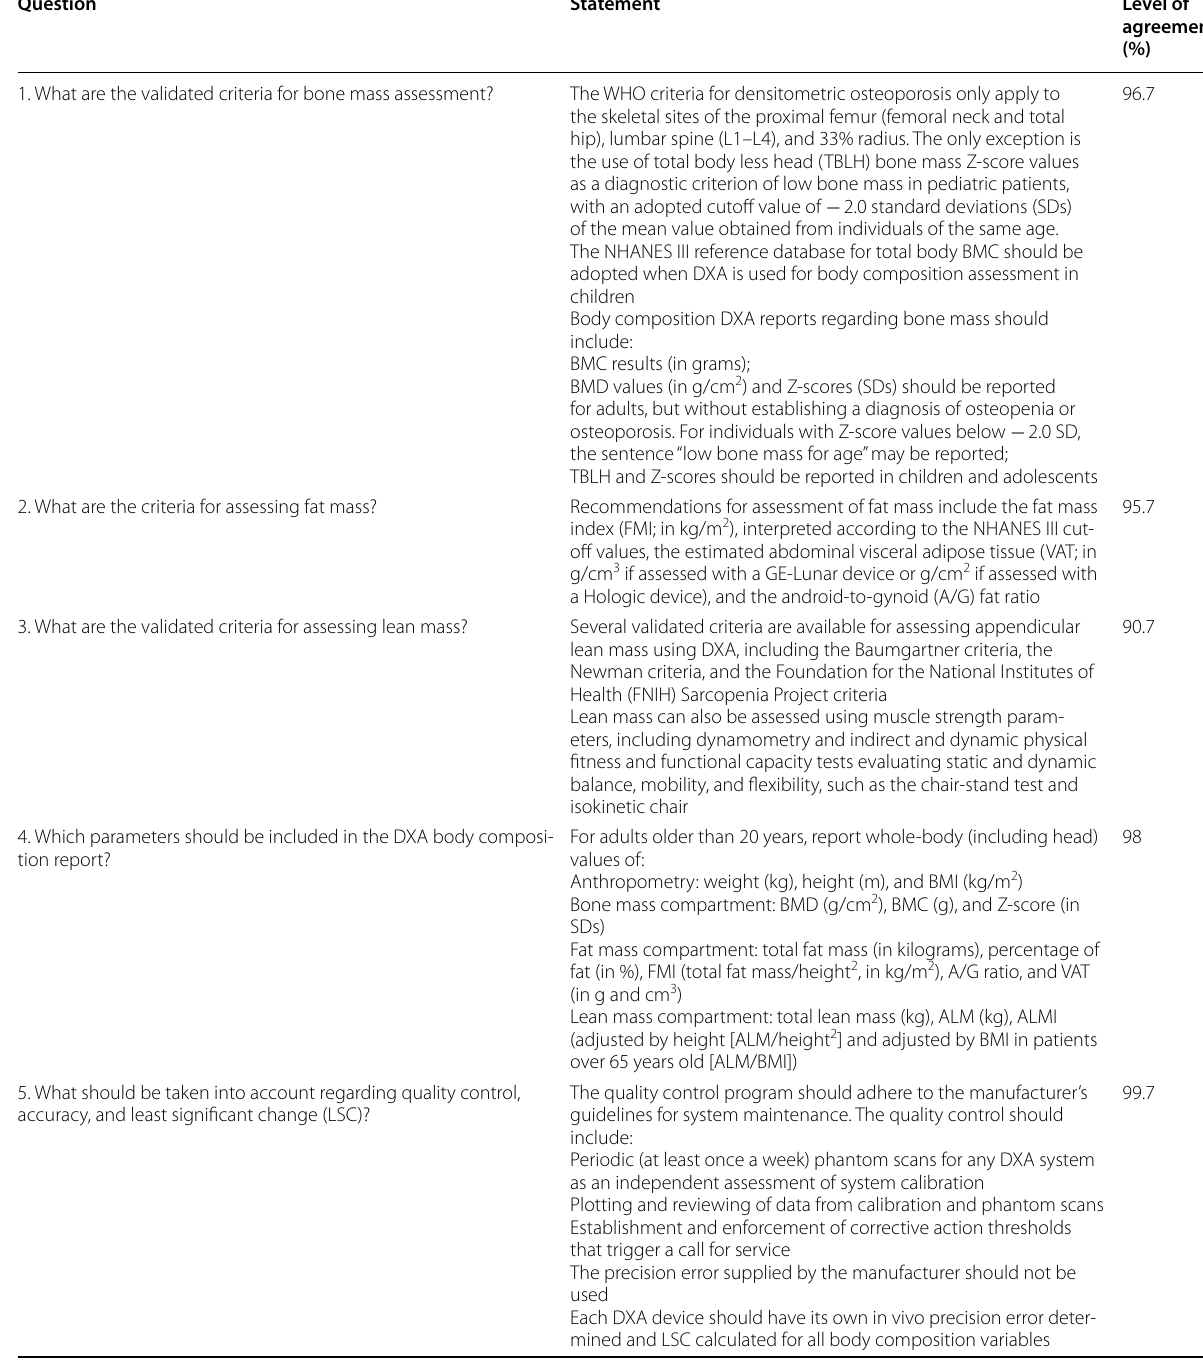
Table 2 Statements from the Official Position of the Brazilian Association of Bone Assessment and Metabolism (ABRASSO) regarding the clinical application of body composition measurements using dual‑energy x‑ray absorptiometry (DXA), along with the levels of agreement (interrater reliability) among the statement’s